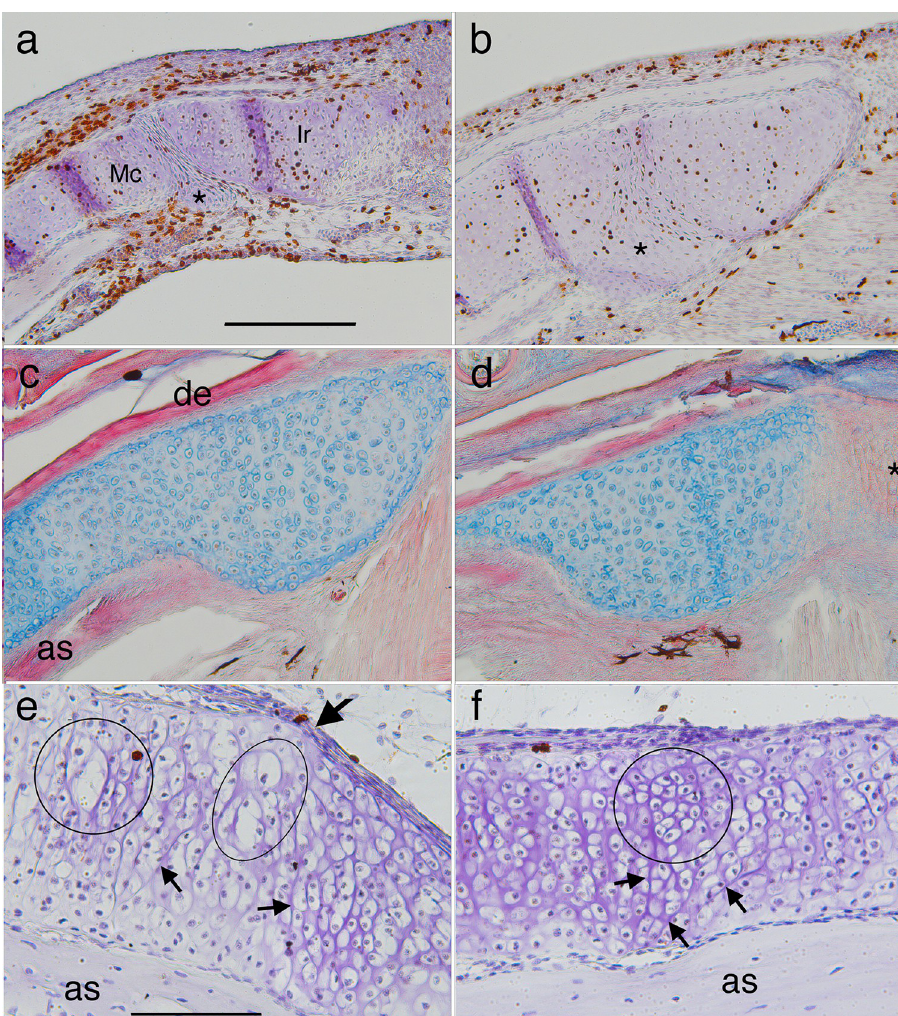
Fig 10. Frontal sections of the proximal (a-d) and middle (e-f) regions of left lower jaws showing metamorphic changes in Meckel’s cartilage (Mc) and infrarostral (Ir). Right is to the midline of the head in a-d and to the proximal region in e-f. (a) a late larval (NF 58) specimen showing a small condensation ( � ) posterior to the joint, and flattened cells in the joint space. (b) a NF 63 specimen showing the condensation having fused with both cartilages, and more matrix around cells in the joint space. (c and d) a NF 65/6 specimen showing alcian blue stained matrix, the dentary bone (de) on the outer edge, the angulosplenial bone (as) on the inner edge, and thin columns of small, unchondrified cells ( � ) in the midline. The absence of matrix in the midline is consistent with this part being bent repeatedly in opposite directions when feeding and ventilating. (E and f) the middle part of a NF 64 left lower jaw at two locations, the inflection point that has just emerged in its outer edge (e, large arrow here and in Fig 1 NF 64), and just proximal to this point (f). E shows large chondrocytes (circle and ellipse) in the outer (more lateral) portion of the cartilage and cluster boundaries running obliquely to its central axis in the inner portion (smaller arrows). F shows a round cell cluster (circle) in the outer portion and more obliquely aligned cluster boundaries in the inner portion (arrows). Scale bars for a-d and e-f are 0.2 and 0.1 mm